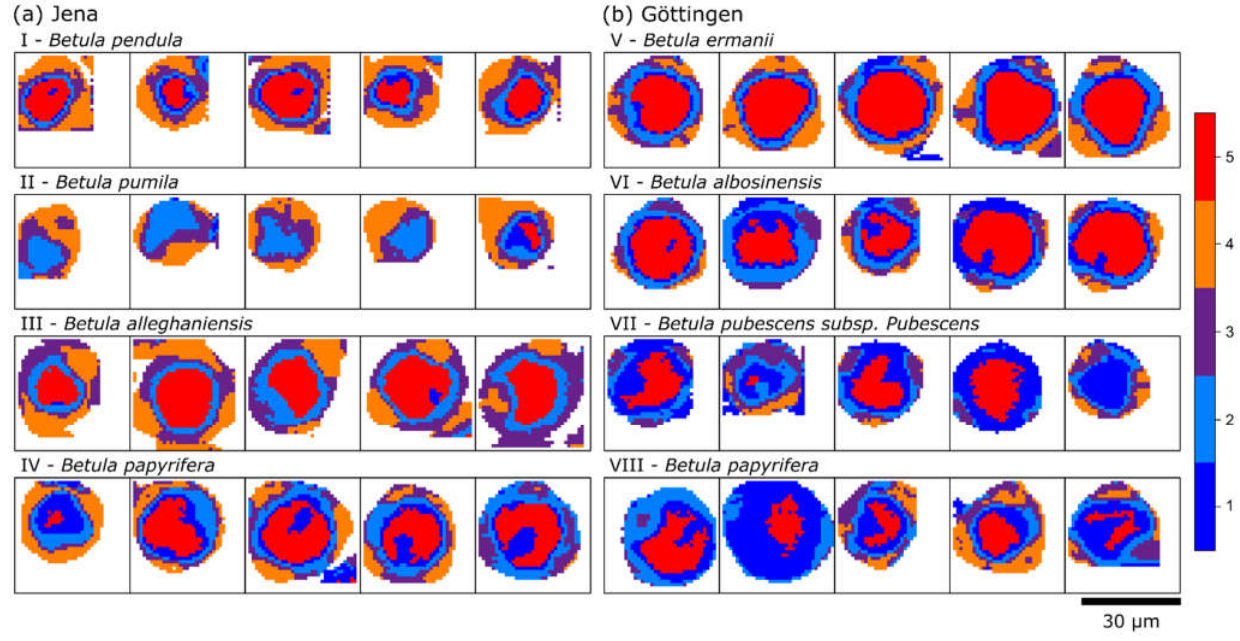
Figure 3. HCA cluster images of 40 pollen grains from two collection sites at ( a ) the Botanic Garden Jena of the Friedrich Schiller University Jena, and ( b ) the Forest Botanical Garden and Arboretum of the University of Göttingen. Five pollen samples from four different Betula species were recorded for each site. The five clusters describe the outer layers and inner core of each pollen grain, and correlate to the cluster spectra in Figure 2b.